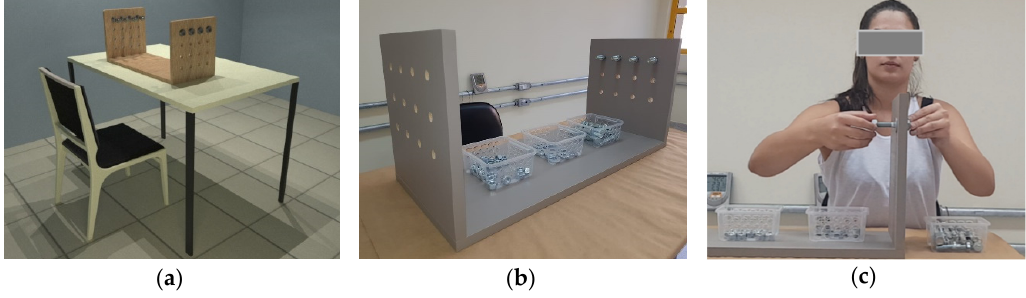
Figure 1. Project of the workstation employed in the study, involving the assembly and disassembly of screws, nuts and ferrules: ( a ) Workstation design; ( b ) Built workstation; and, ( c ) Female participant performing the designed repetitive task.